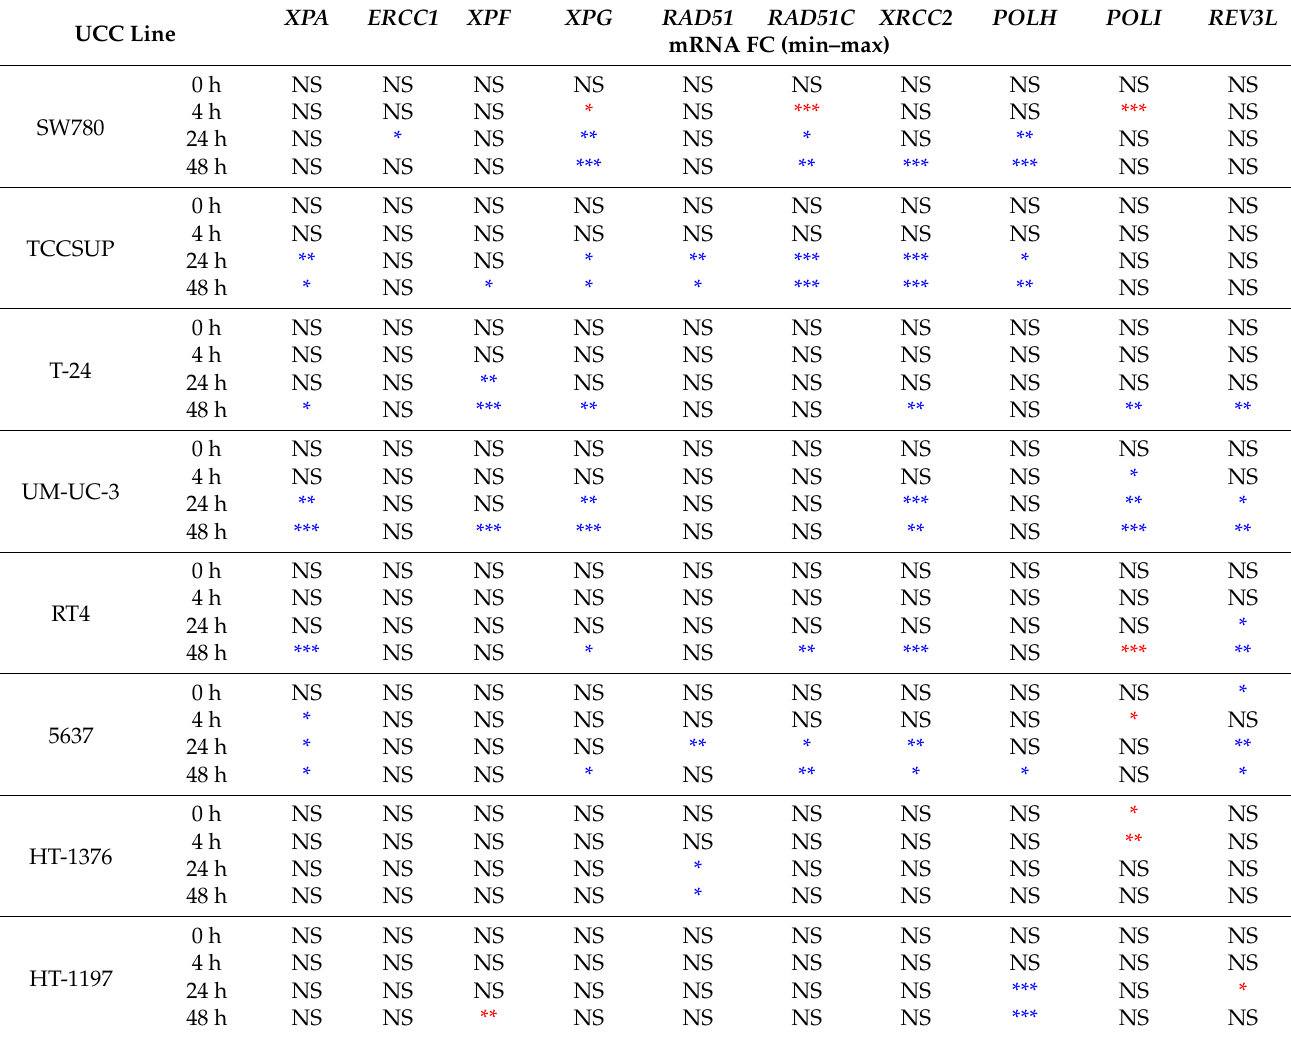
Table 2. Relative expression of the NER, HR and TLS factors after 2 h CDDP treatment at 0, 4, 24 and 48 h. NS, not significant. Blue and red colour refers to an increased and decreased expression due to CDDP treatment, respectively. Statistical significance: * p < 0.05; ** p < 0.01; *** p <